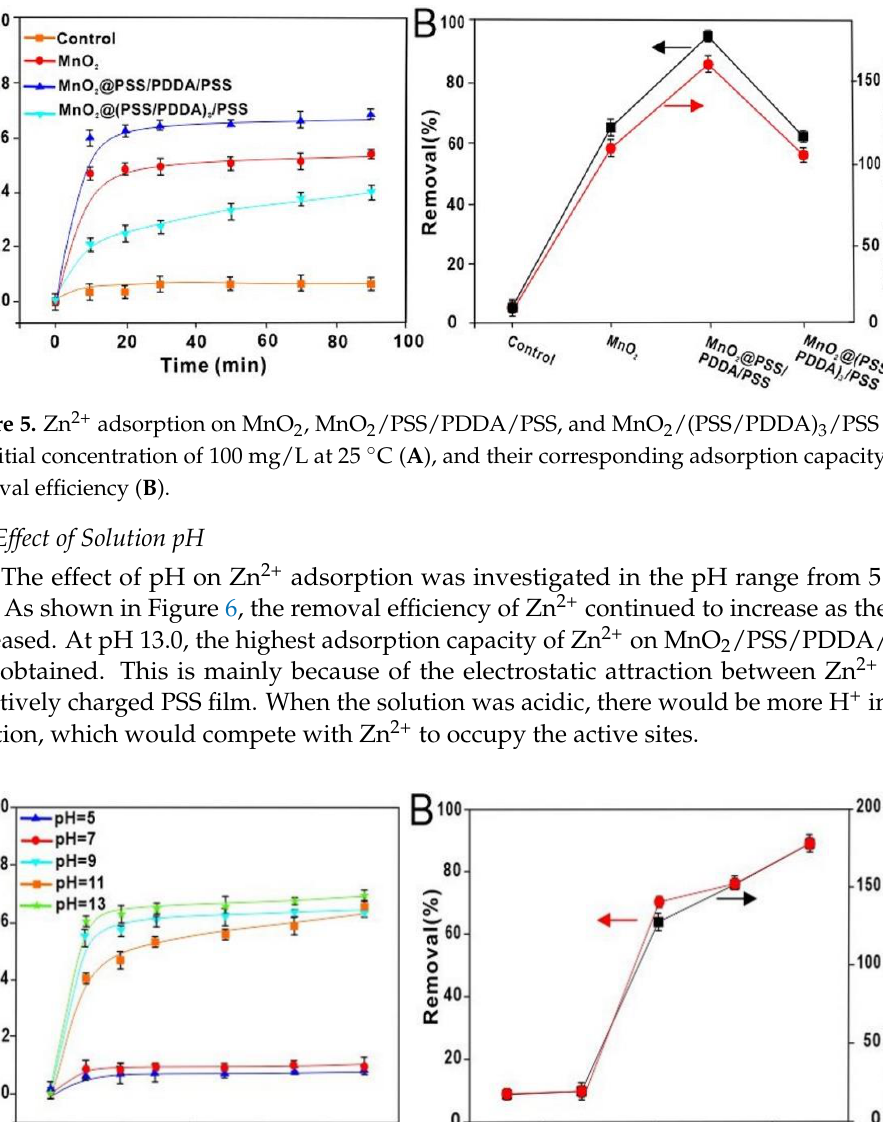
Figure 6. Effect of pH on Zn 2+ adsorption with an initial concentration of 100 mg/L at 25 °C ( A ). Adsorption capacity and removal of Zn 2+ on MnO 2 @PSS/PDDA/PSS at different pH values ( B ).